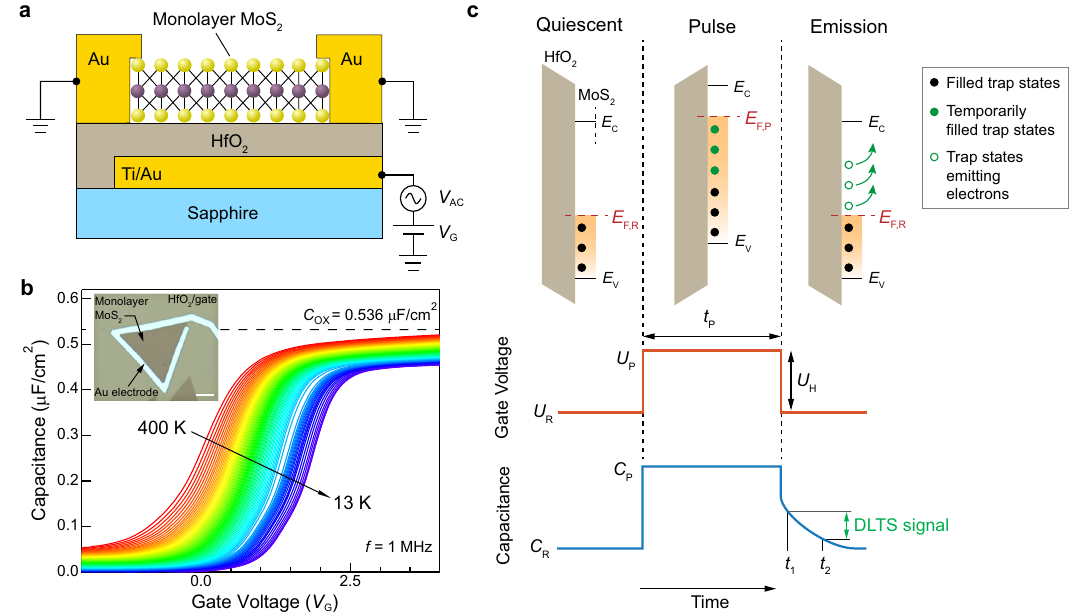
Fig. 1 | Device con fi guration for deep-level transient spectroscopy (DLTS) measurements. a The metal-insulator-semiconductor (MIS) capacitor device con fi guration used for capacitance-voltage (C-V) and DLTS measurements. b Temperature-dependent C-V curve measured using a 1 MHz, 50 mV oscillating signal V AC superposedontheDCgatevoltage V G .Thehorizontal,dottedlinemarks the saturating capacitance from the oxide( C OX ). Theinsetshowsthe opticalimage of the MIS capacitor device. The scale bar is 10 µ m long. c A schematic diagram showing the band alignment, the carrier interaction with trap states, and the vol- tage and capacitance change during the DLTS measurement. The orange-shaded